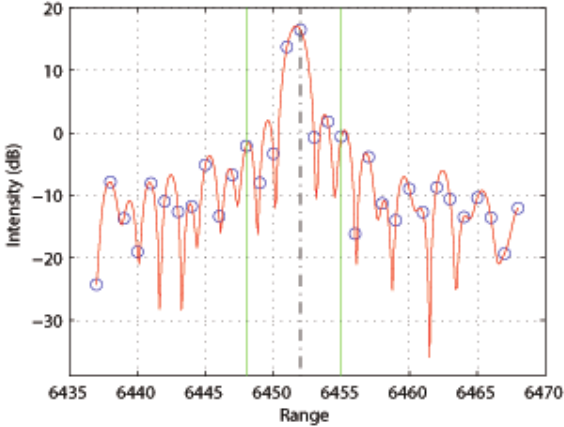
Figure 6. Corner reflector VV response